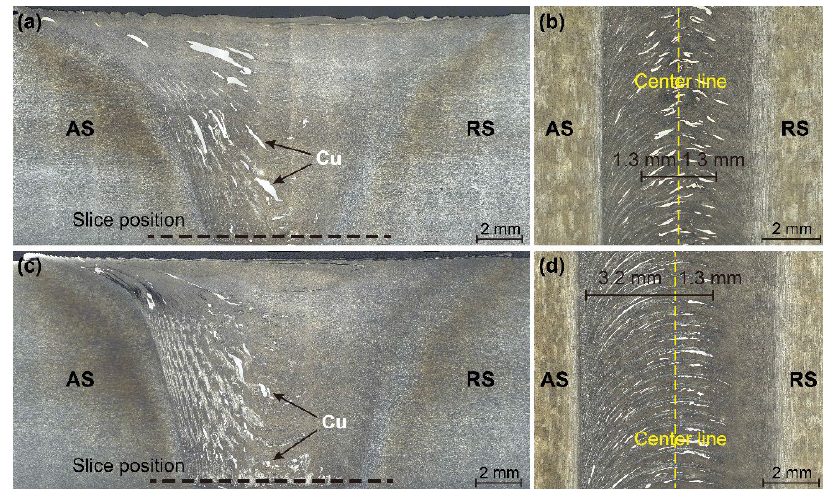
Figure 10. Distribution of deformed copper foil in joints ( a , b ) Pin-1 and ( c , d ) Pin-2.